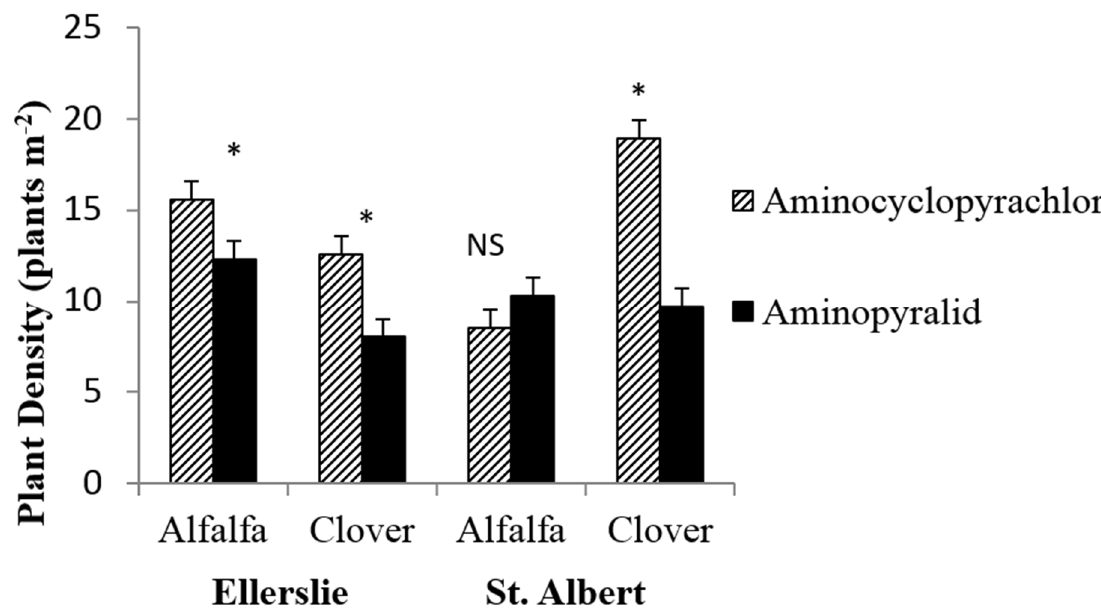
Figure 2. Mean ( ± 1 SE) forage plant density for each of two legume species, alfalfa and white clover, at each of two study locations, following spraying with either aminocyclopyrachlor or aminopyralid herbicide. Means of herbicides within a pair denoted by a * differ, at p < 0.05. NS indicates not significant.